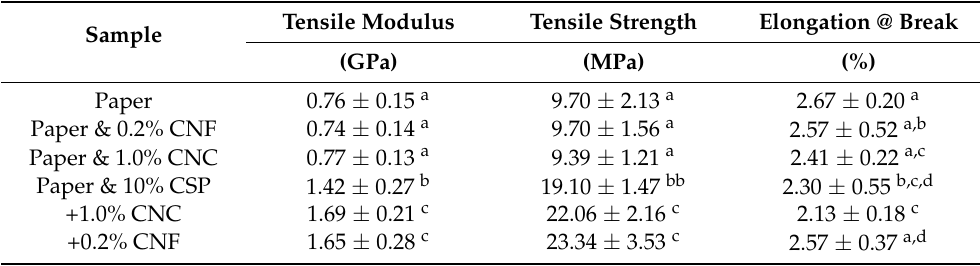
Table 3. Mechanical properties of paper impregnated with cottonseed protein and nanocellulose dispersions.